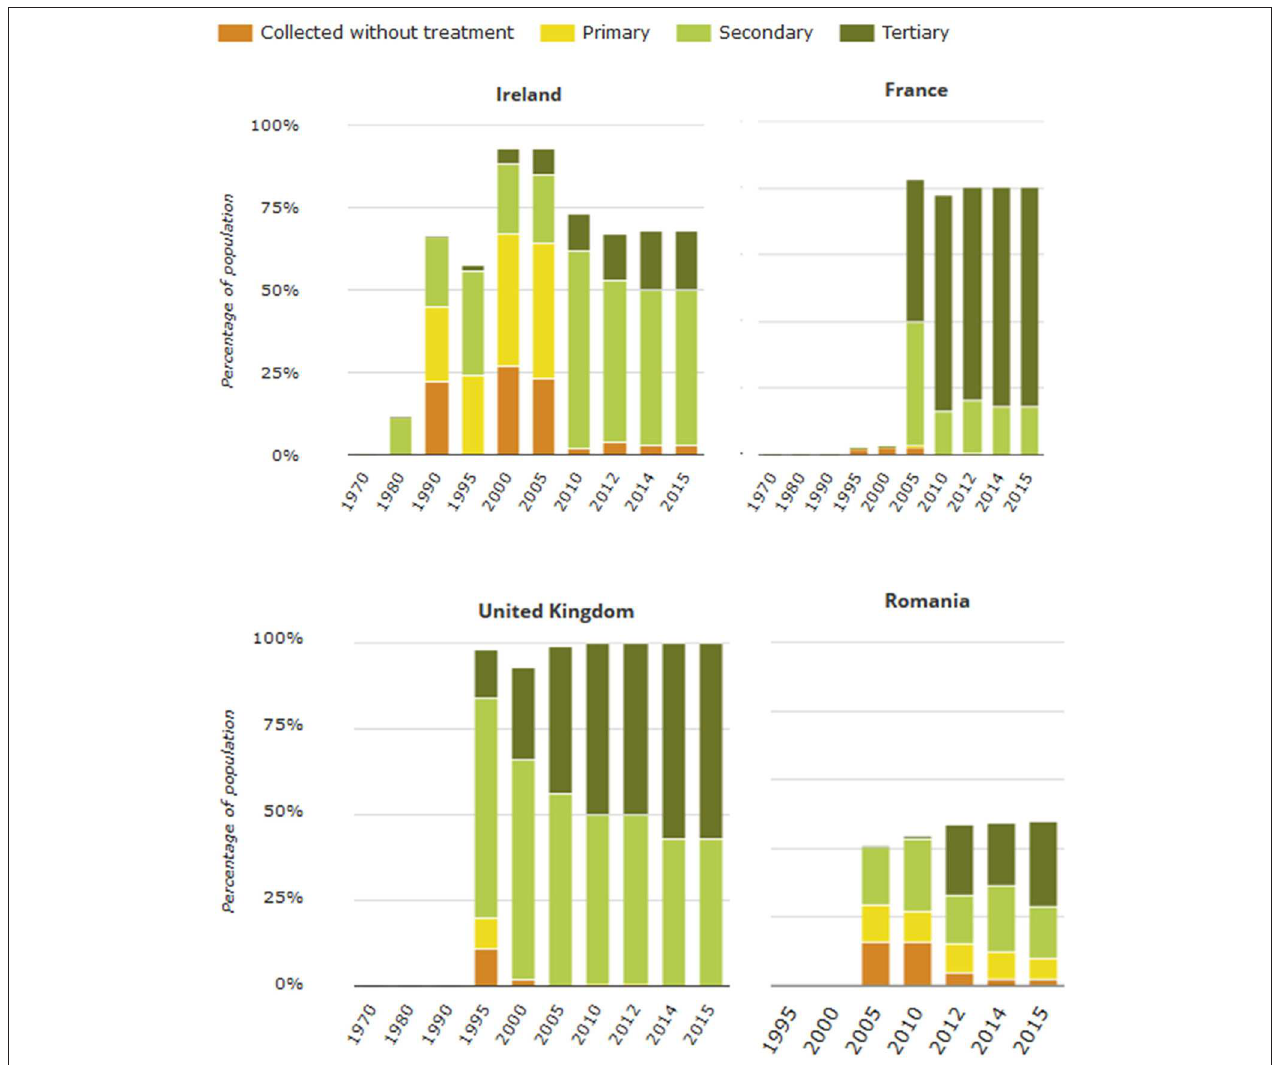
FIGURE 4 | Evolution of wastewater treatment in Ireland, France, UK, Romania (European Environment Agency,